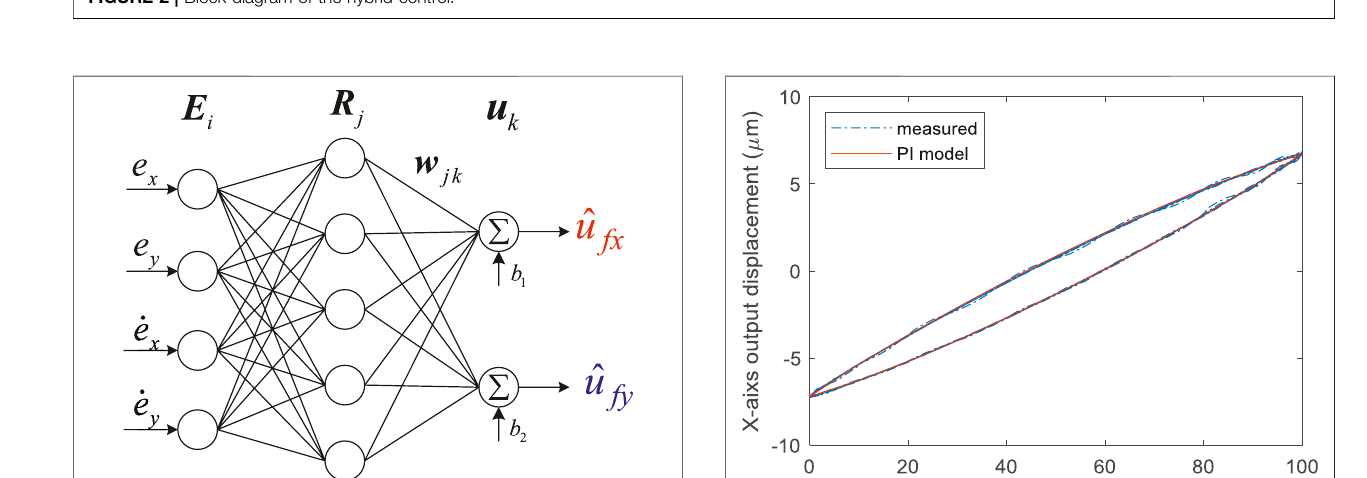
FIGURE 2 | Block diagram of the hybrid control.